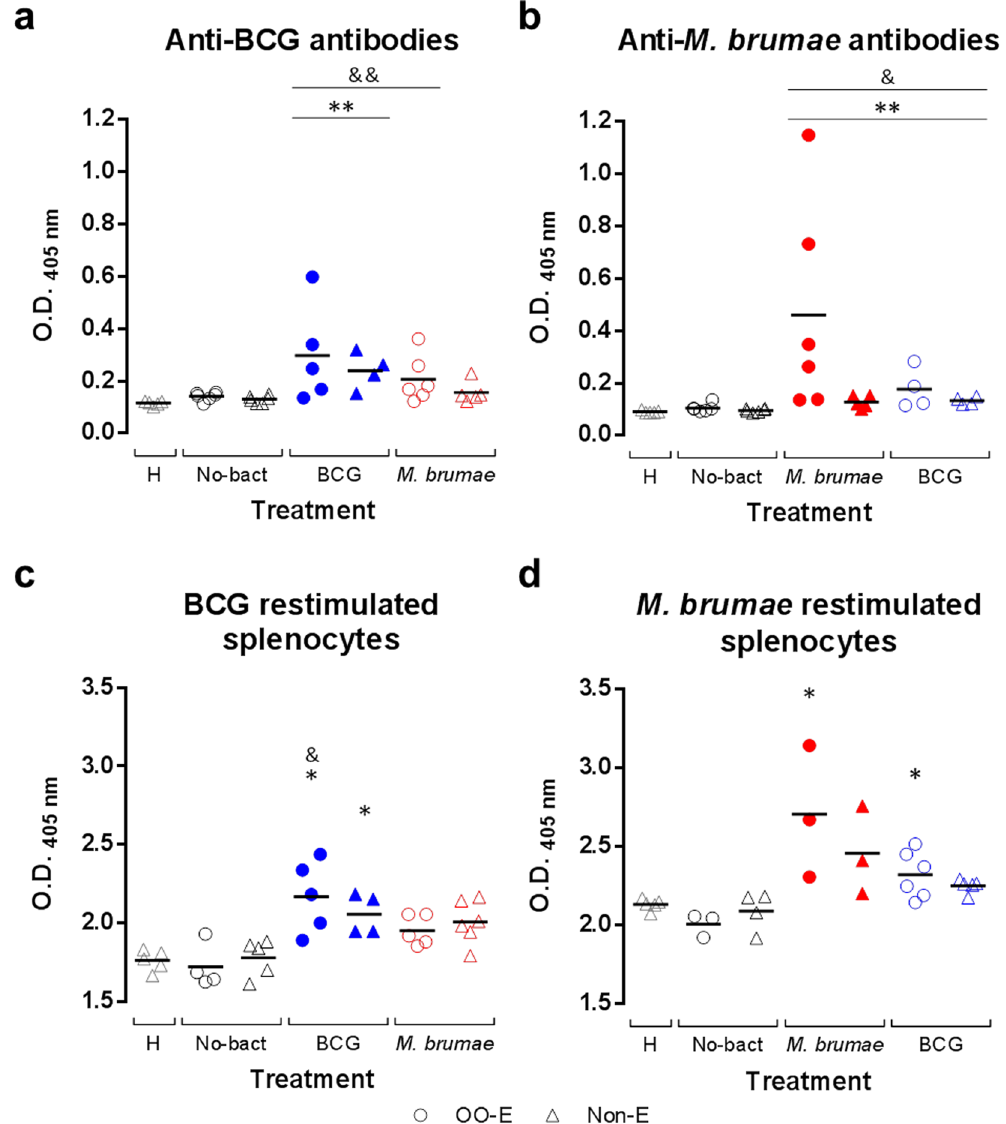
Figure 3. Systemic immune responses in tumor-bearing and healthy mice. Levels of anti-BCG ( a ) and anti- M. brumae ( b ) IgG antibodies present in sera from BCG-treated, M. brumae -treated and non-treated tumor- bearing mice, as well as in healthy animals. The presence of BCG antibodies in M. brumae -treated mouse serum is represented by empty blue symbols ( b ) and the presence of M. brumae antibodies in BCG-treated mouse serum by empty red symbols ( a ). For a and b, solid lines represent the mean of the OD (405 nm) values (two technical replicates) of the six mice from each group. * p < 0.05 compared to No-bact. & p < 0.05 compared to H. Splenocyte proliferation after ex vivo BCG ( c ) and M. brumae ( d ) restimulation. Proliferation is expressed relative to non-restimulated splenocytes of the same animal (proliferation of restimulated splenocytes/proliferation of non-restimulated splenocytes) after BCG and M. brumae stimulation. Proliferation of splenocytes from M. brumae -treated animals restimulated with BCG antigens is represented by empty red symbols ( c ) and proliferation of splenocytes from BCG-treated animals restimulated with M. brumae antigens is represented by empty blue symbols ( d ). For c and d, solid lines represent the mean of relative proliferation (three technical replicates) of 3–6 different spleens from each animal group. * p < 0.05 compared to No-bact. & p < 0.05 compared to H. For a, b, c, and d, dots represent animals treated with emulsified preparations and triangles represent animals treated with non-emulsified preparations. The different groups of animals are indicated by different colors on the horizontal axis of the graph as follows: empty grey triangles for the healthy (H) mice, empty black symbols for tumor-bearing mice receiving no mycobacteria treatment (No-bact), blue symbols for BCG-treated mice, and red symbols for M. brumae -treated